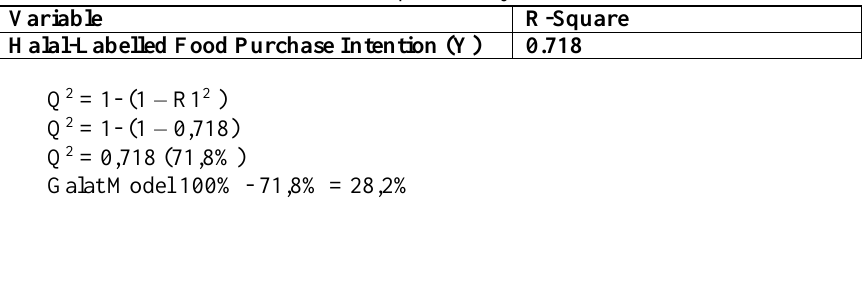
Table 2 R-Square